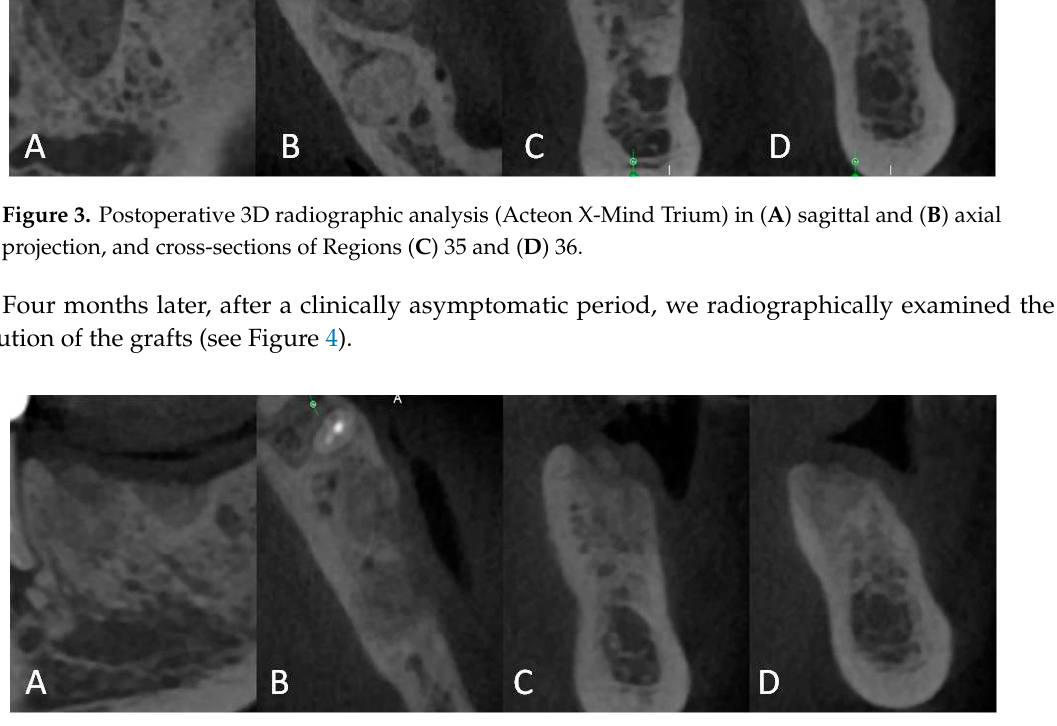
Figure 4. Three-dimensional radiographic analysis (Acteon X-Mind Trium) done four months later, in ( A ) sagittal and ( B ) axial projection, and cross-sections of Regions ( C ) 35 and ( D ) 36.